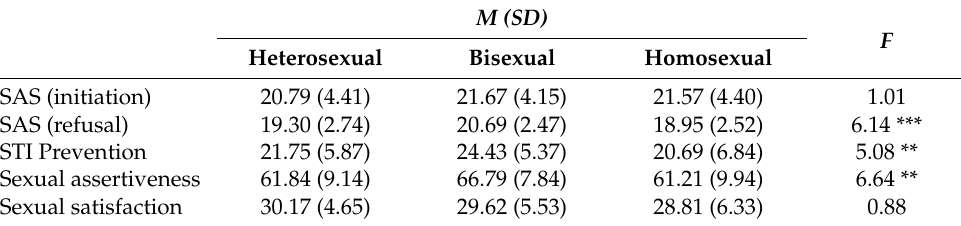
Table 3. ANOVA for comparing sexual assertiveness and sexual satisfaction between groups of sexual